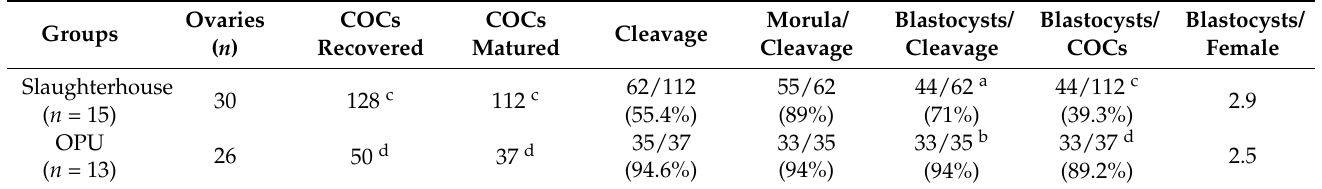
Table 2. Total number of COCs recovered and in vitro matured, cleavage, morula and blastocyst rate and total number of blastocysts produced by female using oocytes collected from slaughterhouse ovaries or in vivo donors using transvaginal follicular aspiration in